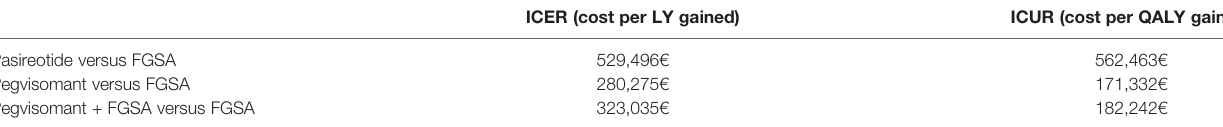
TABLE 7 | ICER and ICUR of the base case.